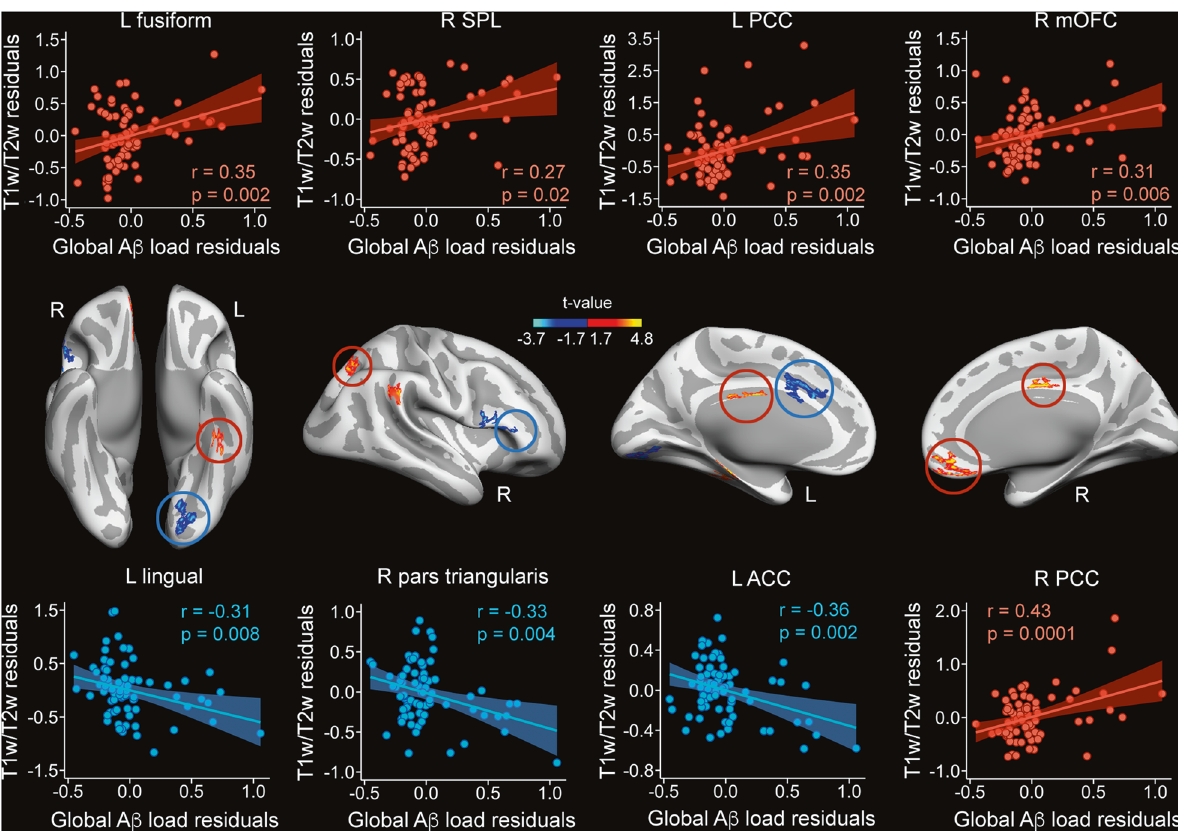
Table 2. Cortical regions showing signi fi cant correlations between global A β load and myelin content. Negative correlations